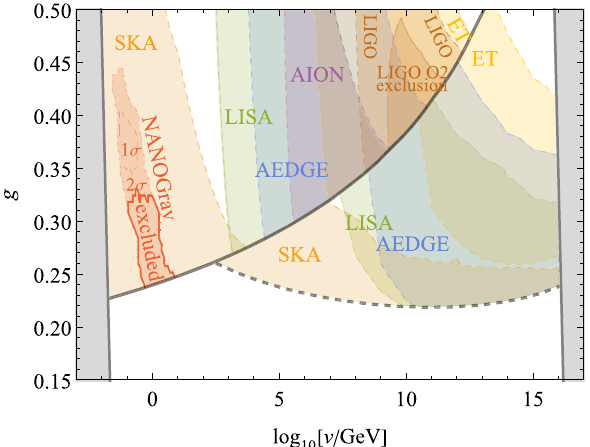
Fig. 6 Regions of the parameter space within reach of various future GW detectors with SNR > 10. Above the solid black curve the super- cooling ends with bubble percolation and below by quantum fluctua- tions. The black dashed curve shows the bound coming from allowed length of the thermal inflation period. Solid brown and red contours indicate, respectively, the exclusions arising from the current LIGO data and PTA observations, while the red dashed contours indicate the regions that fits the recent NANOGrav result with a given confidence